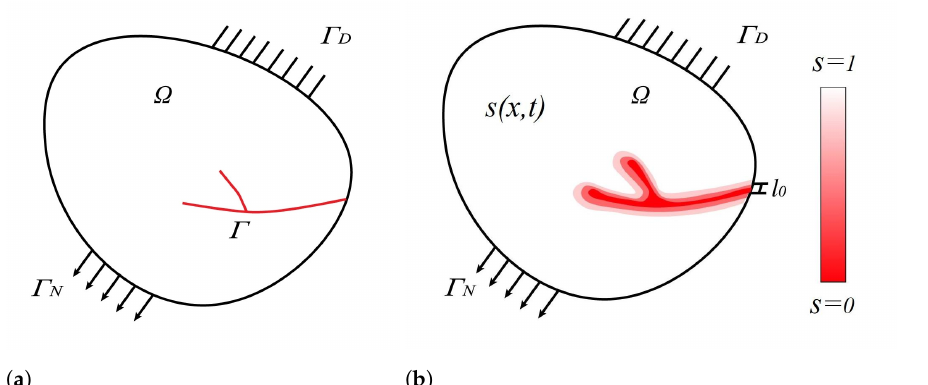
Figure 1. ( a ) Body with internal discontinuity (sharp crack), Γ ; ( b ) approximation of internal disconti- nuity by a phase field